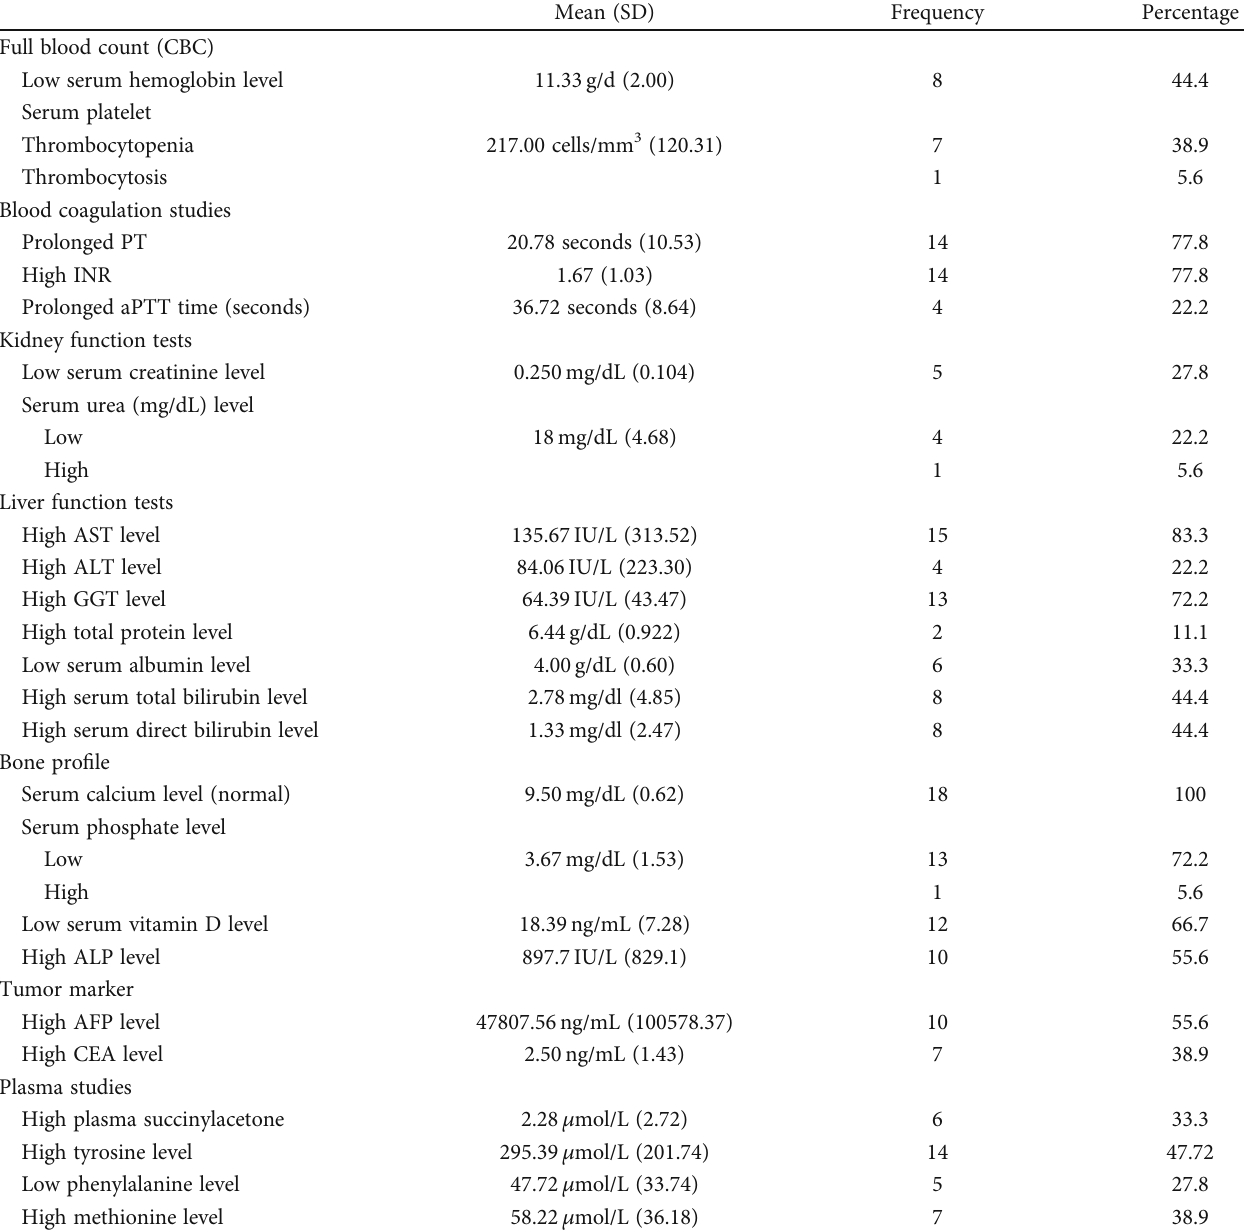
Table 3: Descriptive analysis of the HT1 diagnosed children ’ s presenting laboratory